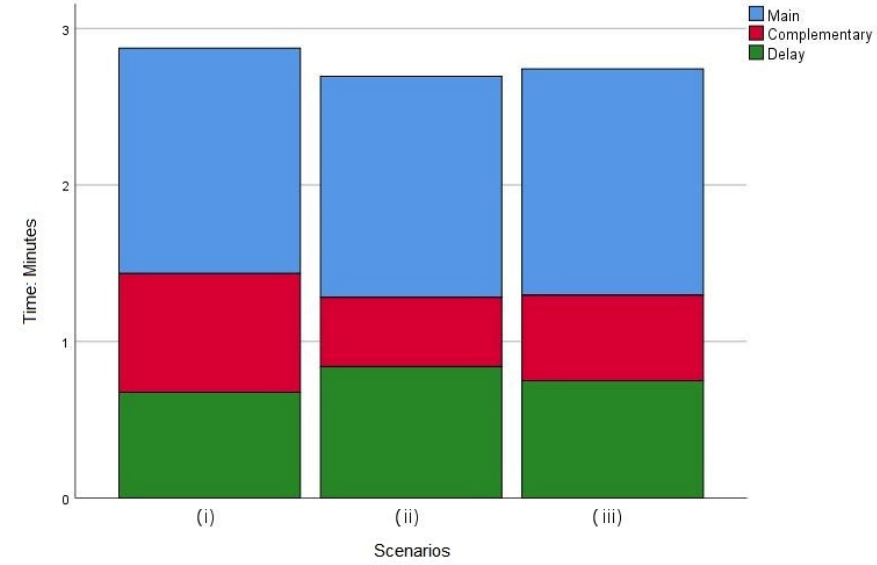
Figure 3. Comparison of average work times referred to the working teams.